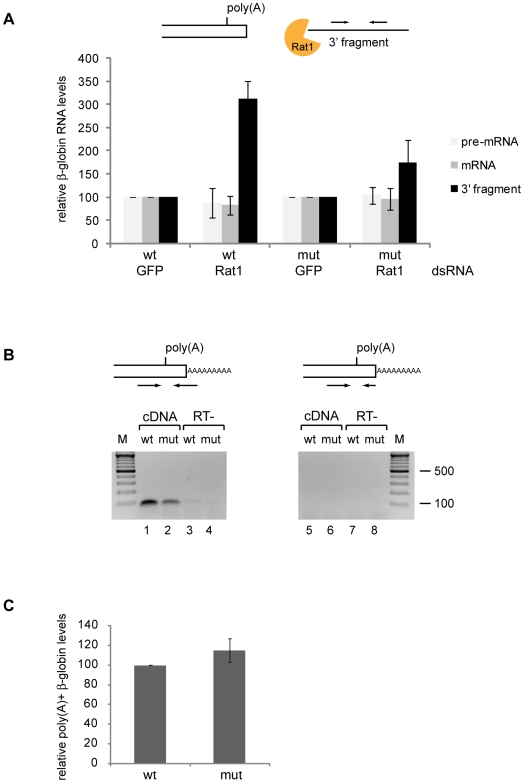
Cleavage and polyadenylation of the β-globin transcripts.(A) Detection of the downstream cleavage product (3′ fragment). The expression of Rat1 was silenced by RNAi in S2 cells expressing either mut or wt β-globin. Control cells were treated in parallel with GFP-dsRNA. Total RNA was purified and reverse-transcribed from dsRNA-treated cells, and the resulting cDNAs were quantified by qPCR with primers specific for the pre-mRNA, the mRNA (see Figure 4A) and the 3′ fragment (see the schematic picture above the histogram). The histogram shows the average values and standard deviations of β-globin levels, normalized to actin 5C RNA, from three independent experiments with two qPCR runs each (n = 6). The relative accumulation of downstream product was less pronounced in cells that expressed the mut β-globin gene than in cells that expressed the wt gene (p<0.01 using a paired, two-tailed Student's t-test, n = 6). (B) PCR-based detection of polyadenylated β-globin transcripts. Total RNA was purified from nuclear preparations of S2 cells expressing either mut or wt β-globin genes. The resulting cDNAs were used to amplify polyadenylated β-globin sequences by PCR with a 26 nt-long downstream primer complementary to the beginning of the poly(A) tail, as indicated in the figure (lanes 1–4). Control reactions with a 16 nt-long primer lacking the oligo(dT) extension were processed in parallel to rule out poly(A)-independent priming (lanes 5–8). Contamination with genomic DNA was assessed in parallel reactions without reverse transcriptase (RT-). (C) RT-qPCR quantification of polyadenylated β-globin transcripts. The samples described above were analyzed by RT-qPCR. Relative levels of polyadenylated β-globin transcripts, normalized to the total β-globin RNA, are shown. Values and standard deviations represent the average from two independent experiments with two qPCR runs each (n = 4). No significant differences were observed using a paired, two-tailed Student's t-test (p = 0.12, n = 4).